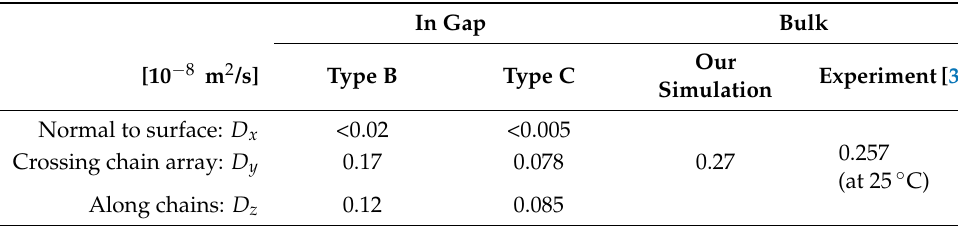
Table 3. Diffusion coefficient of water molecules in the gap region between the cellulose nanocrystal and the oil phase.